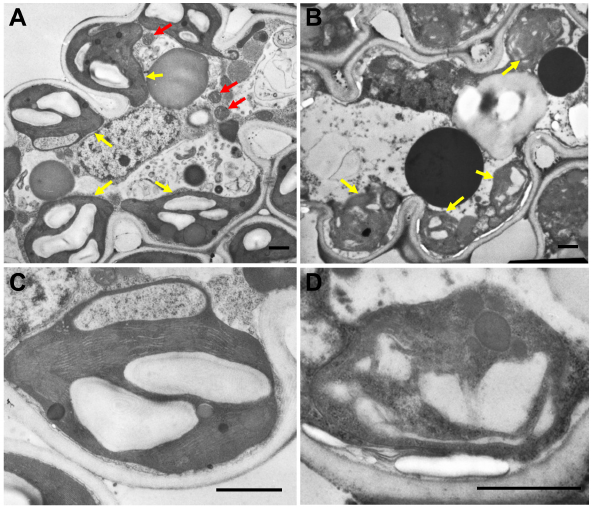
Figure 4. Ultrastructure of chloroplasts in mesophyll cells of flag leaves showing premature senes- cence phenotype at heading stage. ( A , B ) Mesophyll cell of the wild type and lps1 , respectively. ( C , D ) Chloroplast structure of the wild type and lps1 , respectively. Red arrows indicate mitochondria and yellow arrows indicate chloroplasts. Bar = 1 µ m.